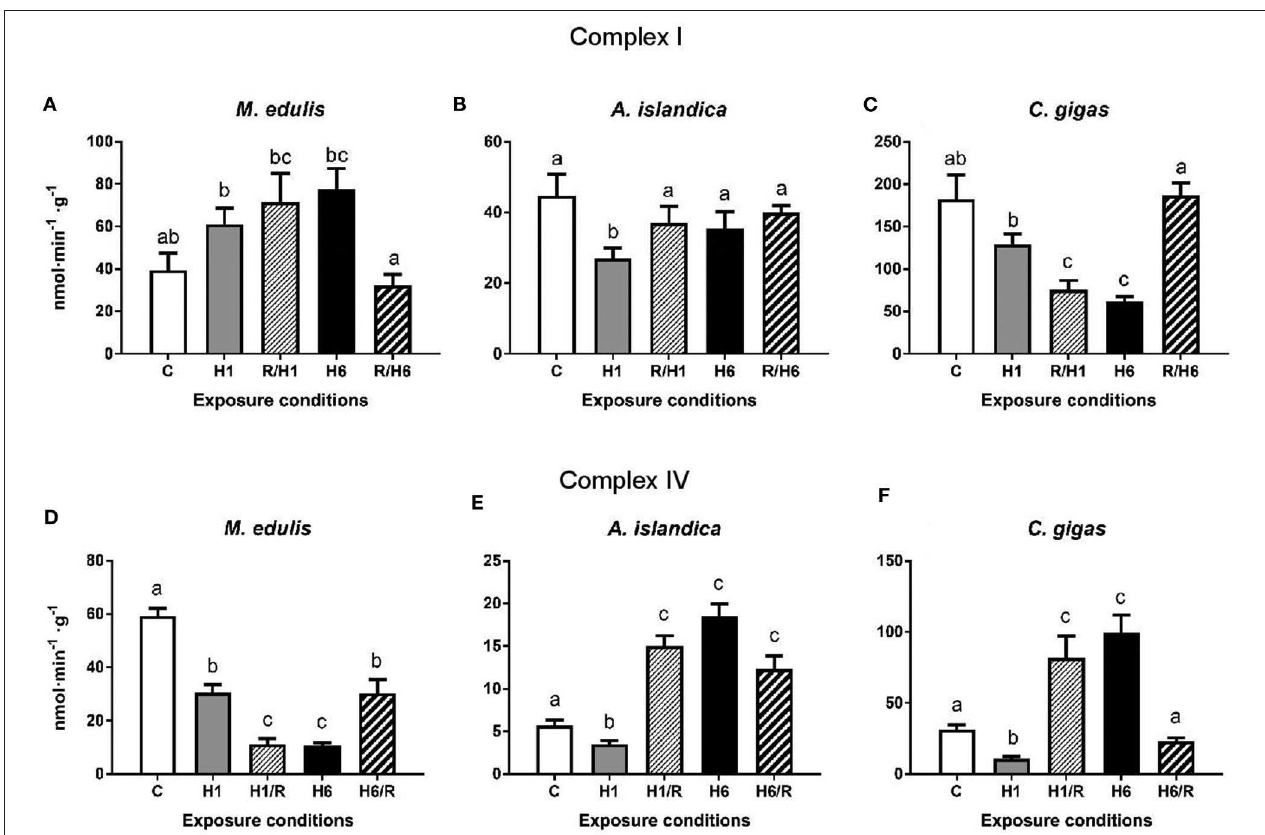
FIGURE 4 | Activities of the mitochondrial Complexes I and IV in the digestive gland of three species of marine bivalves during the exposure to H/R stress. (A,D) The mussels M. edulis , (B,E) the quahogs A. islandica , and (C,F) the oysters C. gigas . (A–C) The activity of mitochondrial Complex I, (D–F) the activity of mitochondrial Complex IV. Enzymes were isolated in the presence of phosphatase and kinase inhibitors to preserve the native phosphorylation state. Exposure conditions are control (normoxia), 1 day hypoxia (H1), 1h reoxygenation following 1 day of hypoxia (H1/R), 6 days of hypoxia (H6), and 1h reoxygenation following 6 days of hypoxia (H6/R). Activities are expressed in nmol product per minute per gram wet tissue mass. Columns that do not share a letter represent significantly different values ( p < 0.05). The vertical bars represent S.E.M. N =